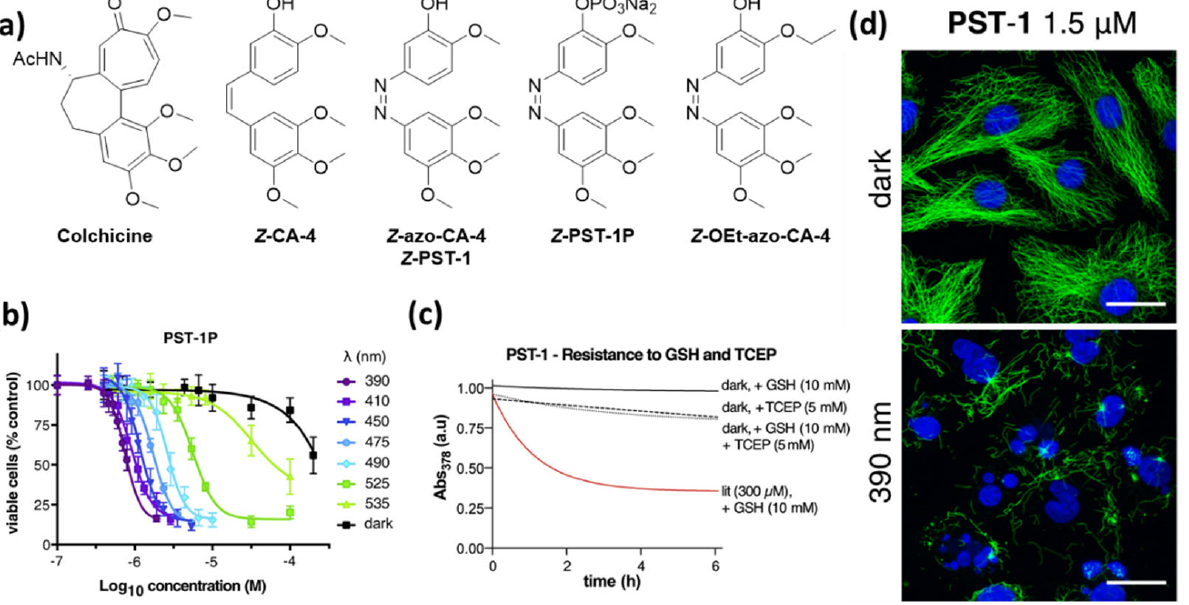
Figure 4. ( a ) Photoswitchable azologues of Combretastatin A ‐ 4 ( CA ‐ 4 ) discussed in this review. ( b ) Viability assays demonstrate the light ‐ tunable potency of PST ‐ 1P . ( c ) E ‐ PST ‐ 1 is stable in presence of GSH but degraded by the reducing agent TCEP. The corresponding photoisomer Z ‐ PST ‐ 1 de ‐